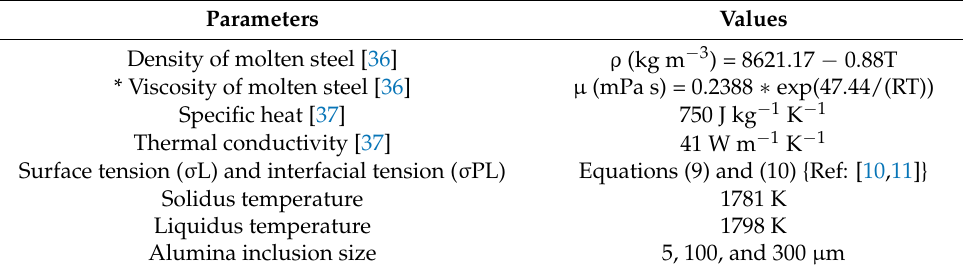
Table 2. Thermo-physical properties of SPFH590 steel.